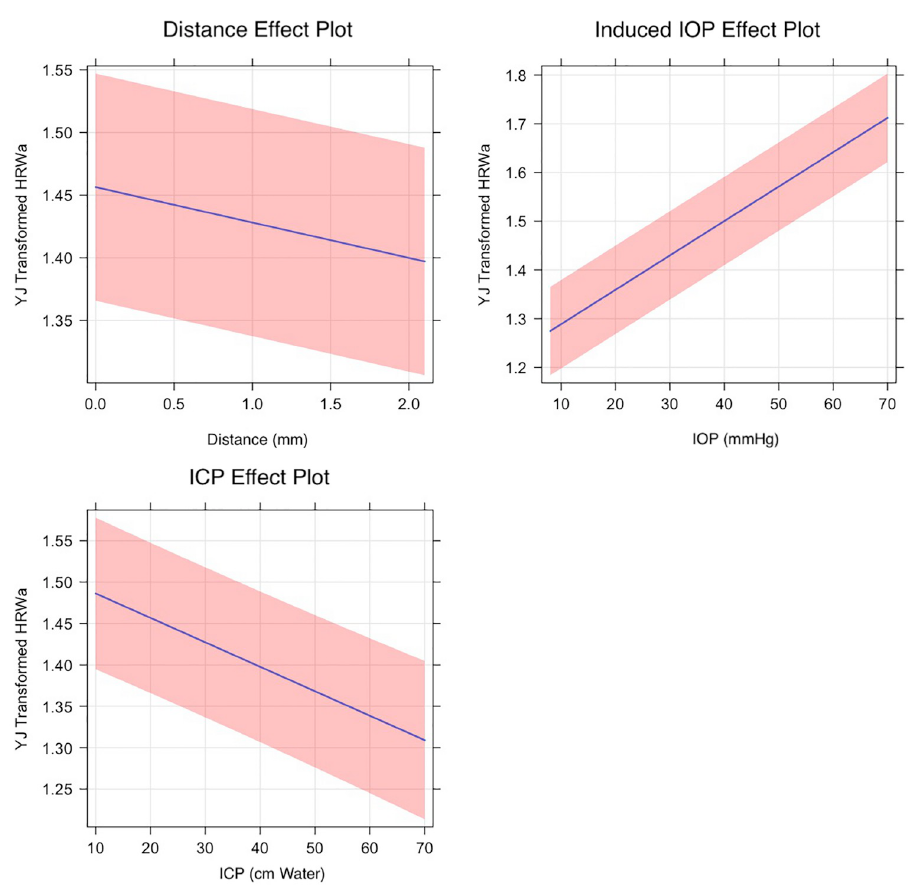
Fig 4. Effect plot of the retinal arterial harmonic regression waveform amplitude (HRW a ). The slope of regression line correlating the HRW a with V Dist was -0.028 ± 0.0021 whereas that correlating with ICP was -0.0031 ± 0.0004. There was amplification of the HRW a as indicated by a positive slope of regression with IOP i , was 0.0071 ± 0.000065 for all coefficients p-value <